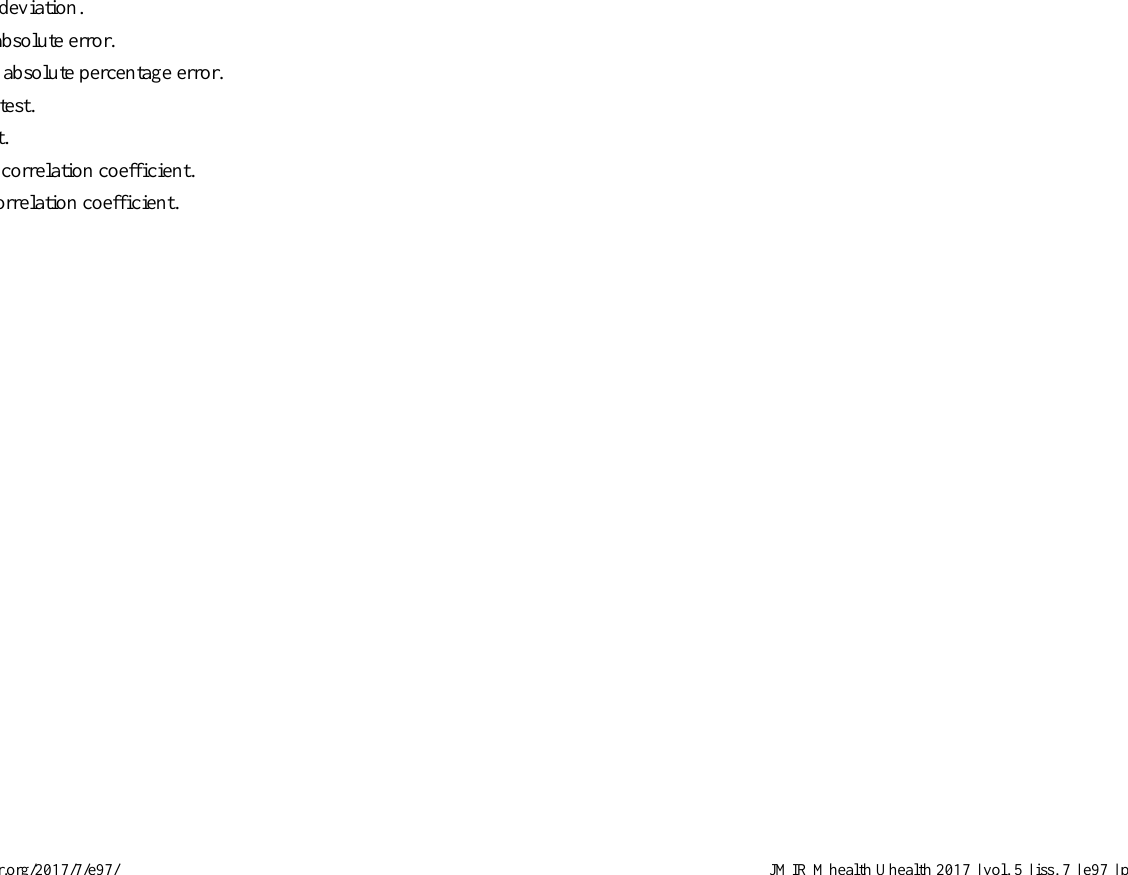
Female (n=11)Male (n=13)All (N=24)Performance